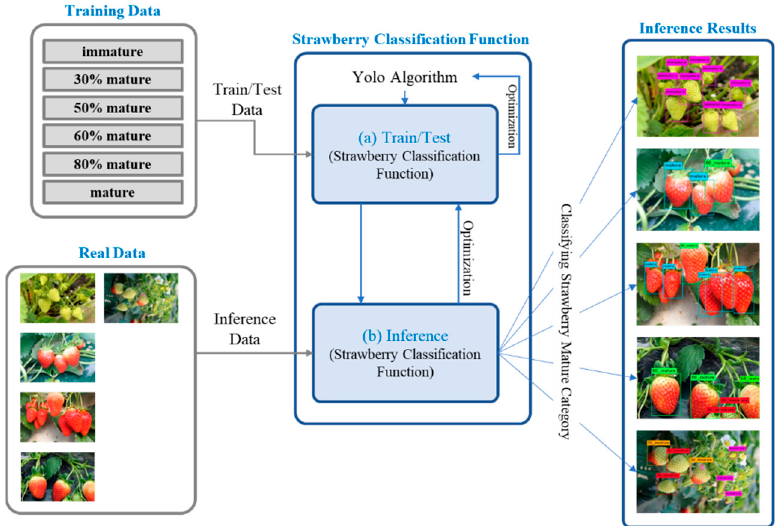
Figure 4. Strawberry harvest decision function workflow.